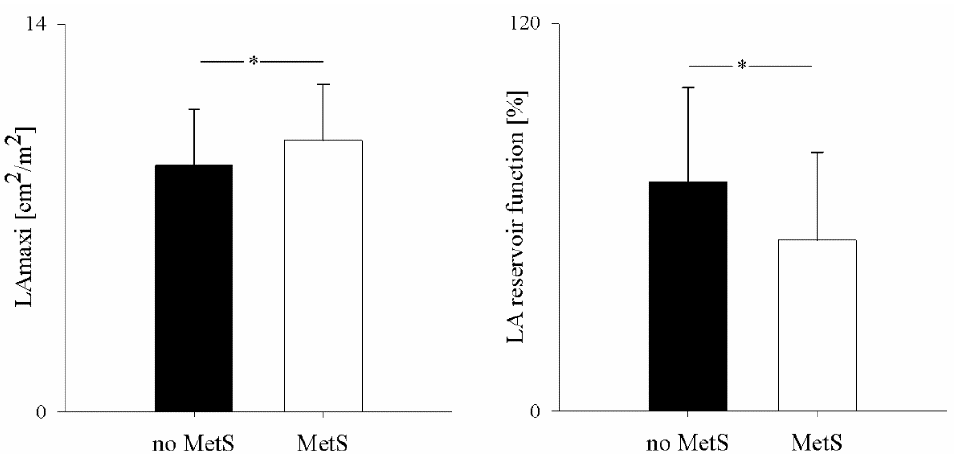
Figure 1. Left panel: Comparison of indexed monoplane 4-chamber maximal left atrial area (LAmaxi) in subjects without Metabolic Syndrome (no MetS) (black bars) and with MetS (MetS) (white bars); right panel: comparison of LA reservoir function in no MetS (black bars) and MetS subjects (white bars); * p < 0.01 Mets vs. no MetS.